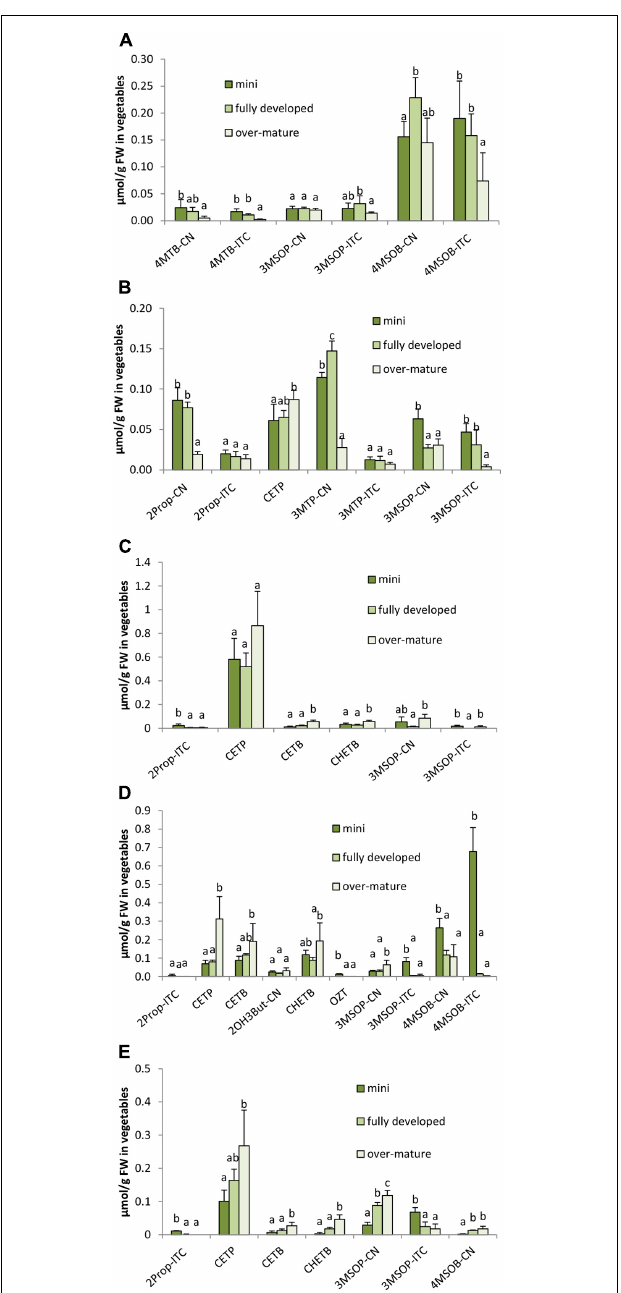
FIGURE 8 | Influence of head ontogeny on the glucosinolate hydrolysis products [ µ mol/g FW] in broccoli (A) , cauliflower (B) , white cabbage (C) , red cabbage (D) , and savoy cabbage (E) . Abbreviations: see Table 2 . Small letters indicate significant differences between means of glucosinolate hydrolysis products concentrations of different head developmental stages ( p ≤ 0.05) as determined by Tukey’s HSD